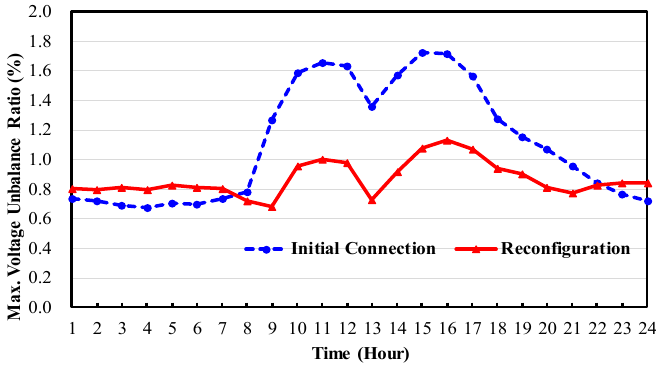
Figure 8. Comparison of the improvement in the Max. voltage imbalance ratio for the industrial feeder on a daily scale.